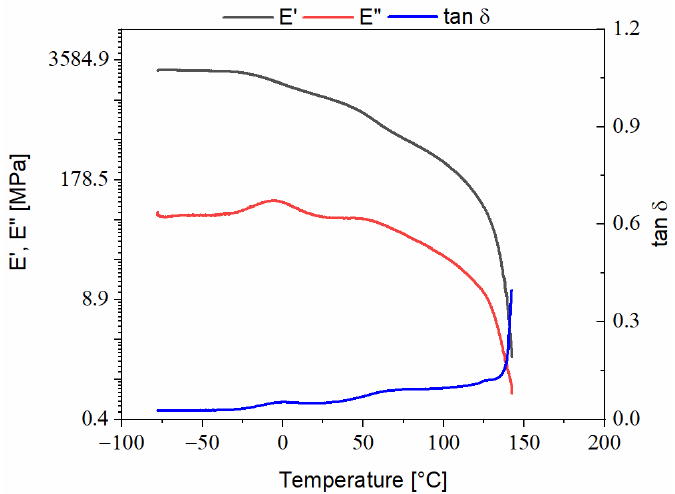
Figure 3. DMA thermogram recorded during heating of Arbofill ® Fichte. Arboform ® LV3 Nature reinforced with aramid fibers, Figure 4: